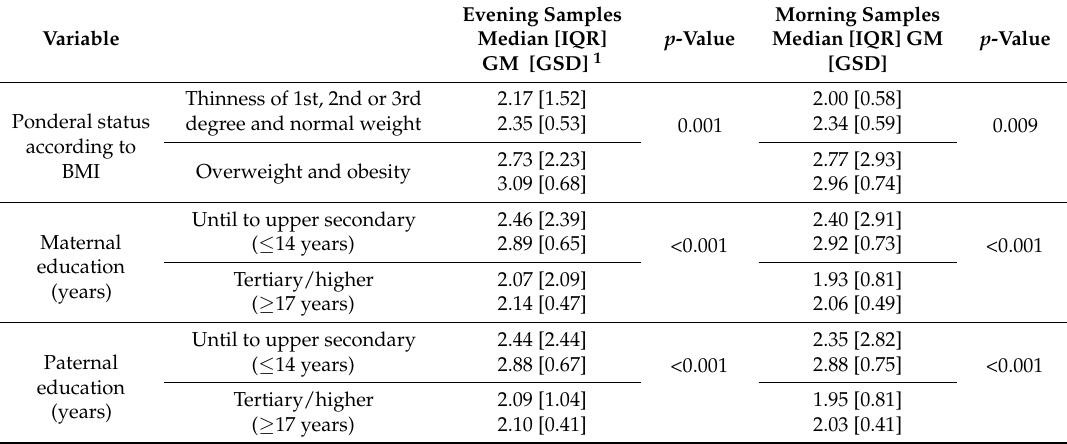
Table 5. Univariate analyses of the u-cotinine levels expressed as µ g L − 1 (independently for evening and morning urine samples) for ponderal status according to Body Mass Index (BMI), mother's and father’s educational level.